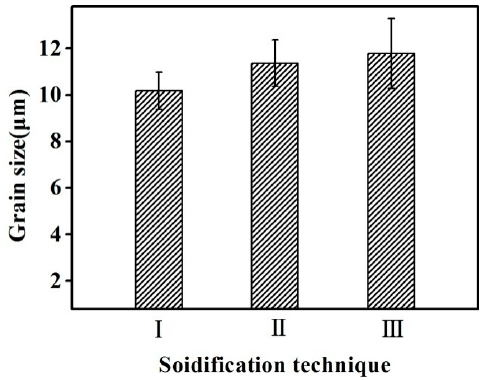
Figure 10. Average Fe grain sizes with various solidification techniques.